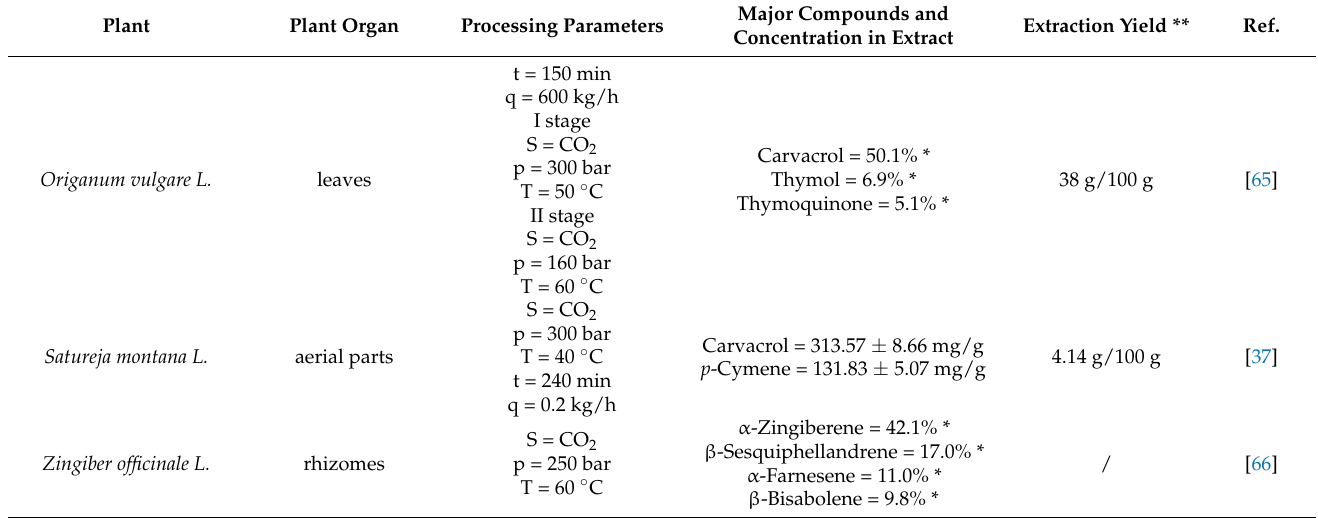
Table 1. Plants and their parts subjected to supercritical fluid extraction to obtain extracts and major compounds in isolated